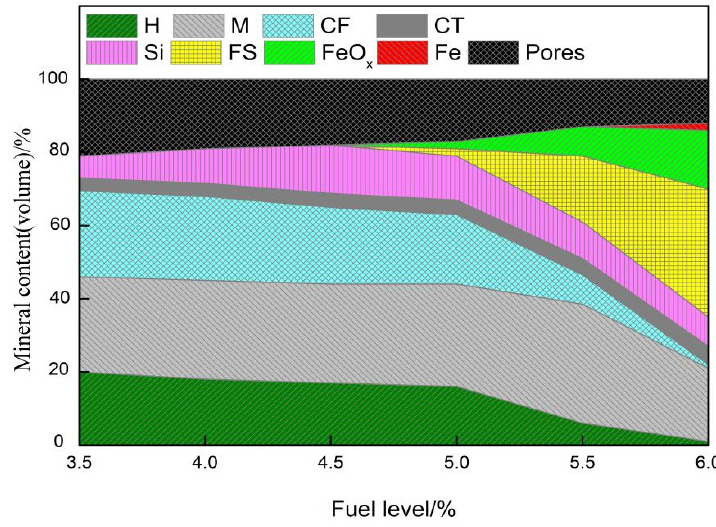
Figure 6. Mineralogy variation of RVT sinter at different fuel levels (H: hematite, M: magnetite, CF: calcium ferrite, Si: silicate (dicalcium silicate, glass, etc), CT: perovskite, FS: fayalite).